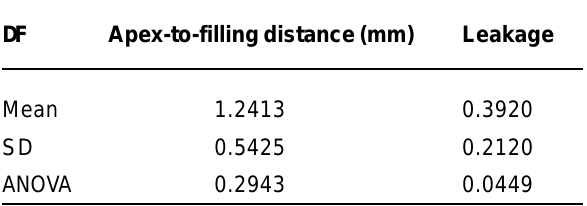
TABLE 6- Statistical data for the disrupted-filled (DF)